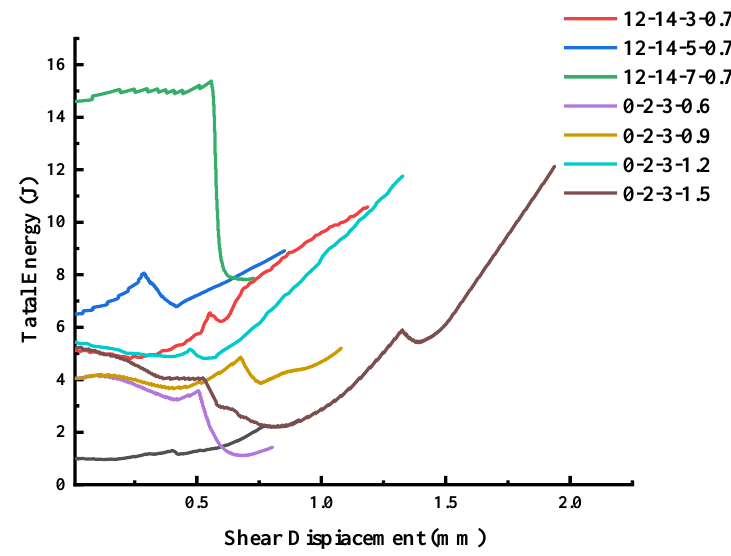
Figure 17. Total